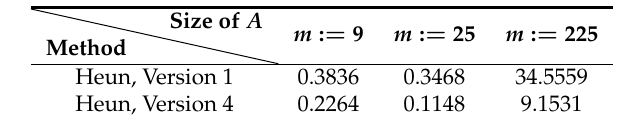
Table 1. Results of a comparison between the runtimes (in seconds) of the Heun method in its Versions 1 and 4.